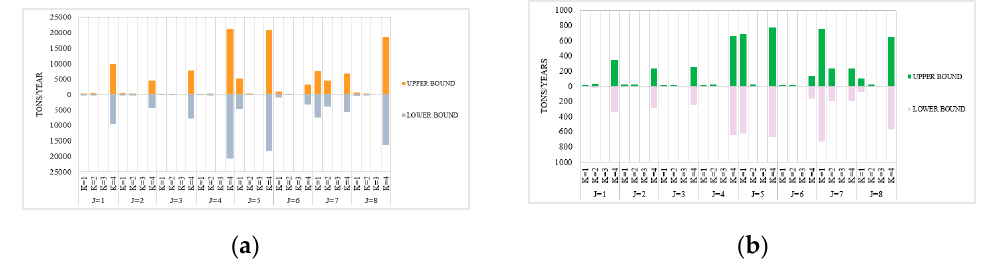
Figure 1. The emissions of COD and ammonia nitrogen from different water use departments in different areas of the Yinma River Basin in the first planning period. ( a ) The emissions of COD in the first planning period; ( b ) The emissions of ammonia nitrogen in the first planning period.